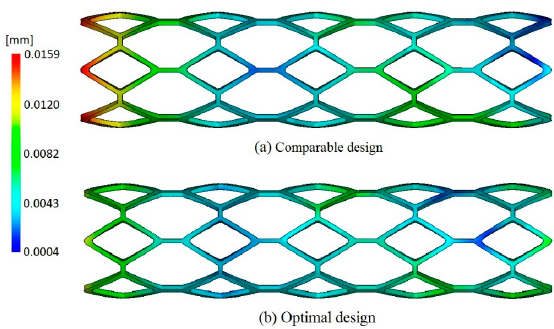
Figure 9. The distribution of warpage of the comparable design and optimal design.